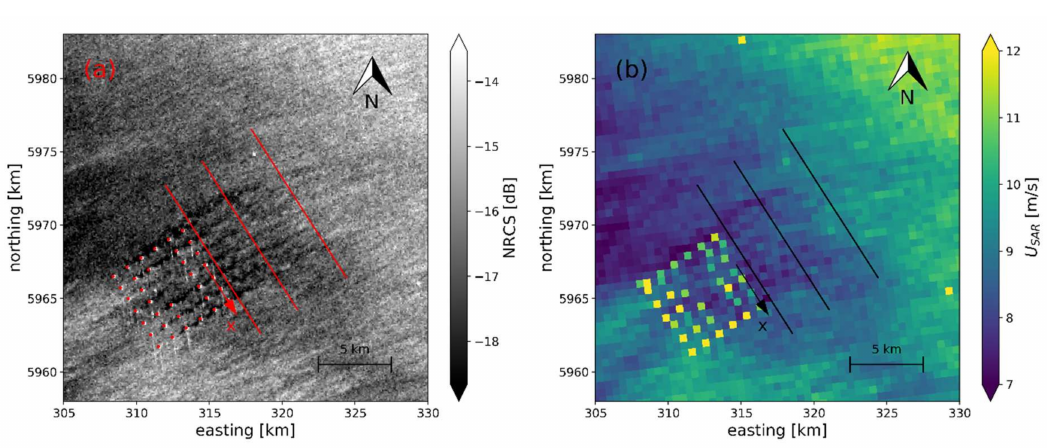
Figure 5. Sentinel-1A SAR image from 04-10-2017 at 17:04. a) NRCS at 40 m resolution. Turbine positions are indicated as red dots and transects at 700 m, 3700 m, and 7700 m downstream as red lines. b) Retrieved SAR wind speed with 500m pixel size.